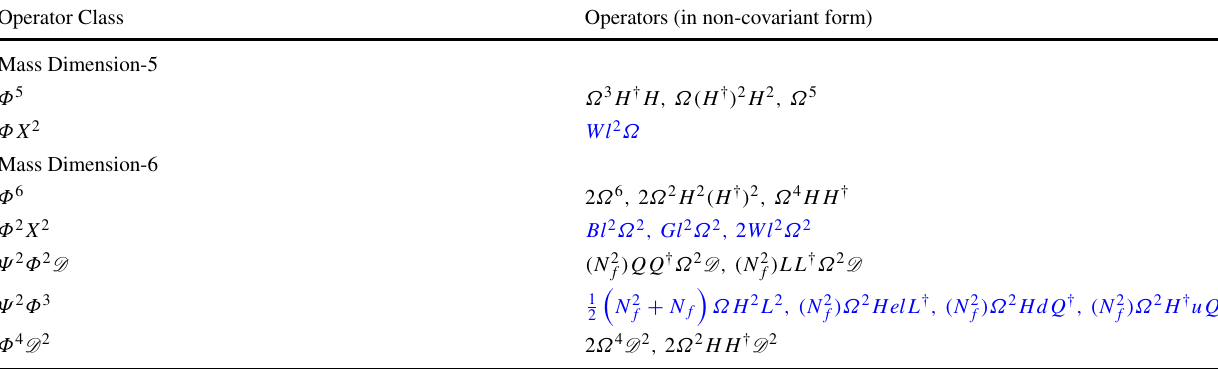
Table 35 SM + SU ( 2 ) quintuplet scalar( Ω ): operators of mass dimensions-5 and -6 excluding pure SM